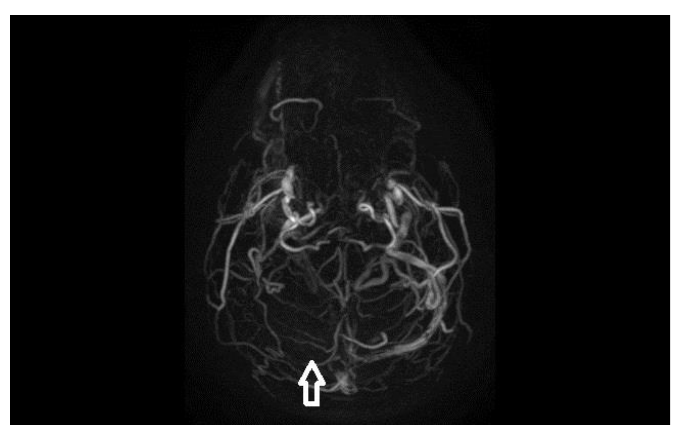
Figure 2. Magnetic resonance venography of the brain demonstrating lack of flow in right transverse sinus